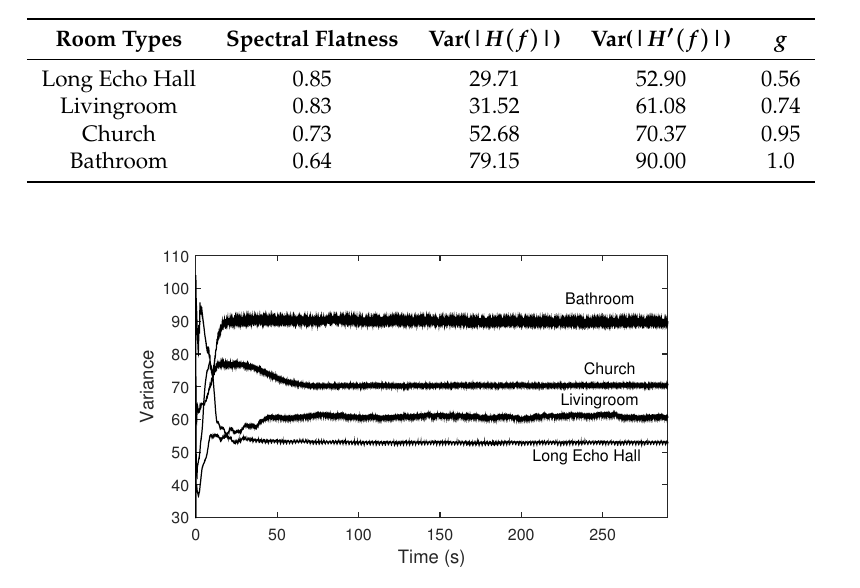
Figure 11. Variances of magnitudes of transfer functions simulated using impulse response data of several locations with different distributions of room modes (measured in Table